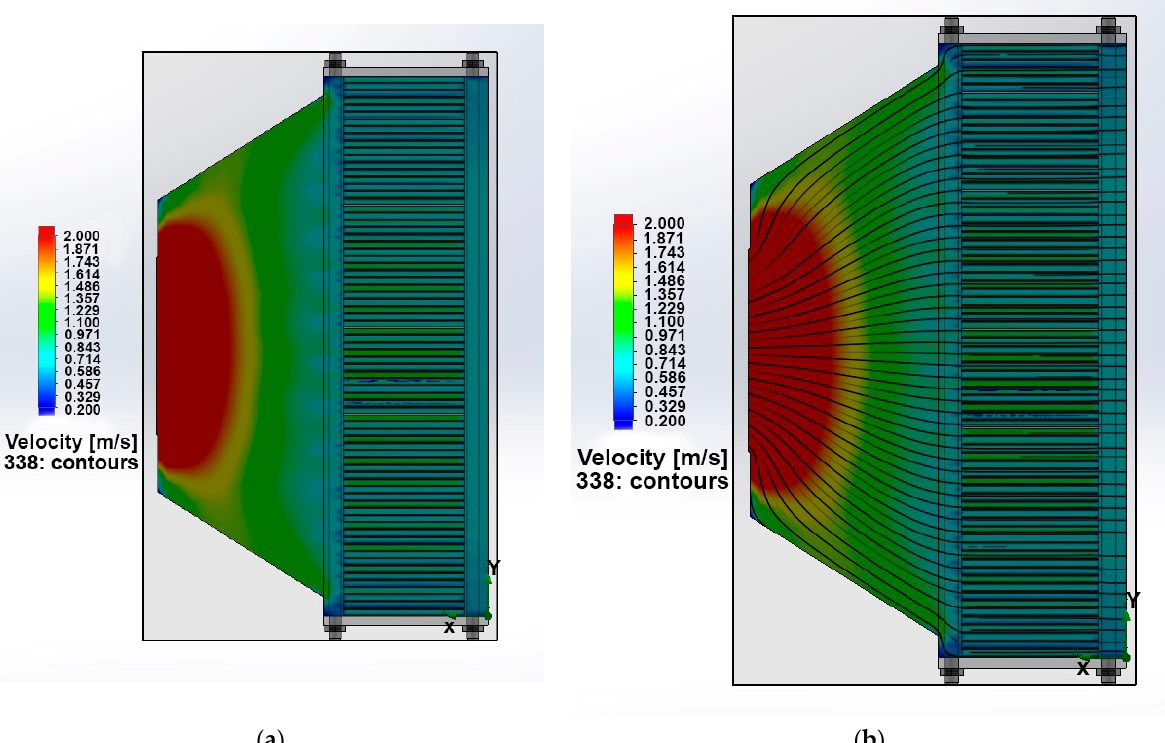
Figure 5. ( a ) The velocity fields of the cooling and oxidizing agent in the longitudinal section of the PEMFC stack without streamlines and ( b ) with streamlines.